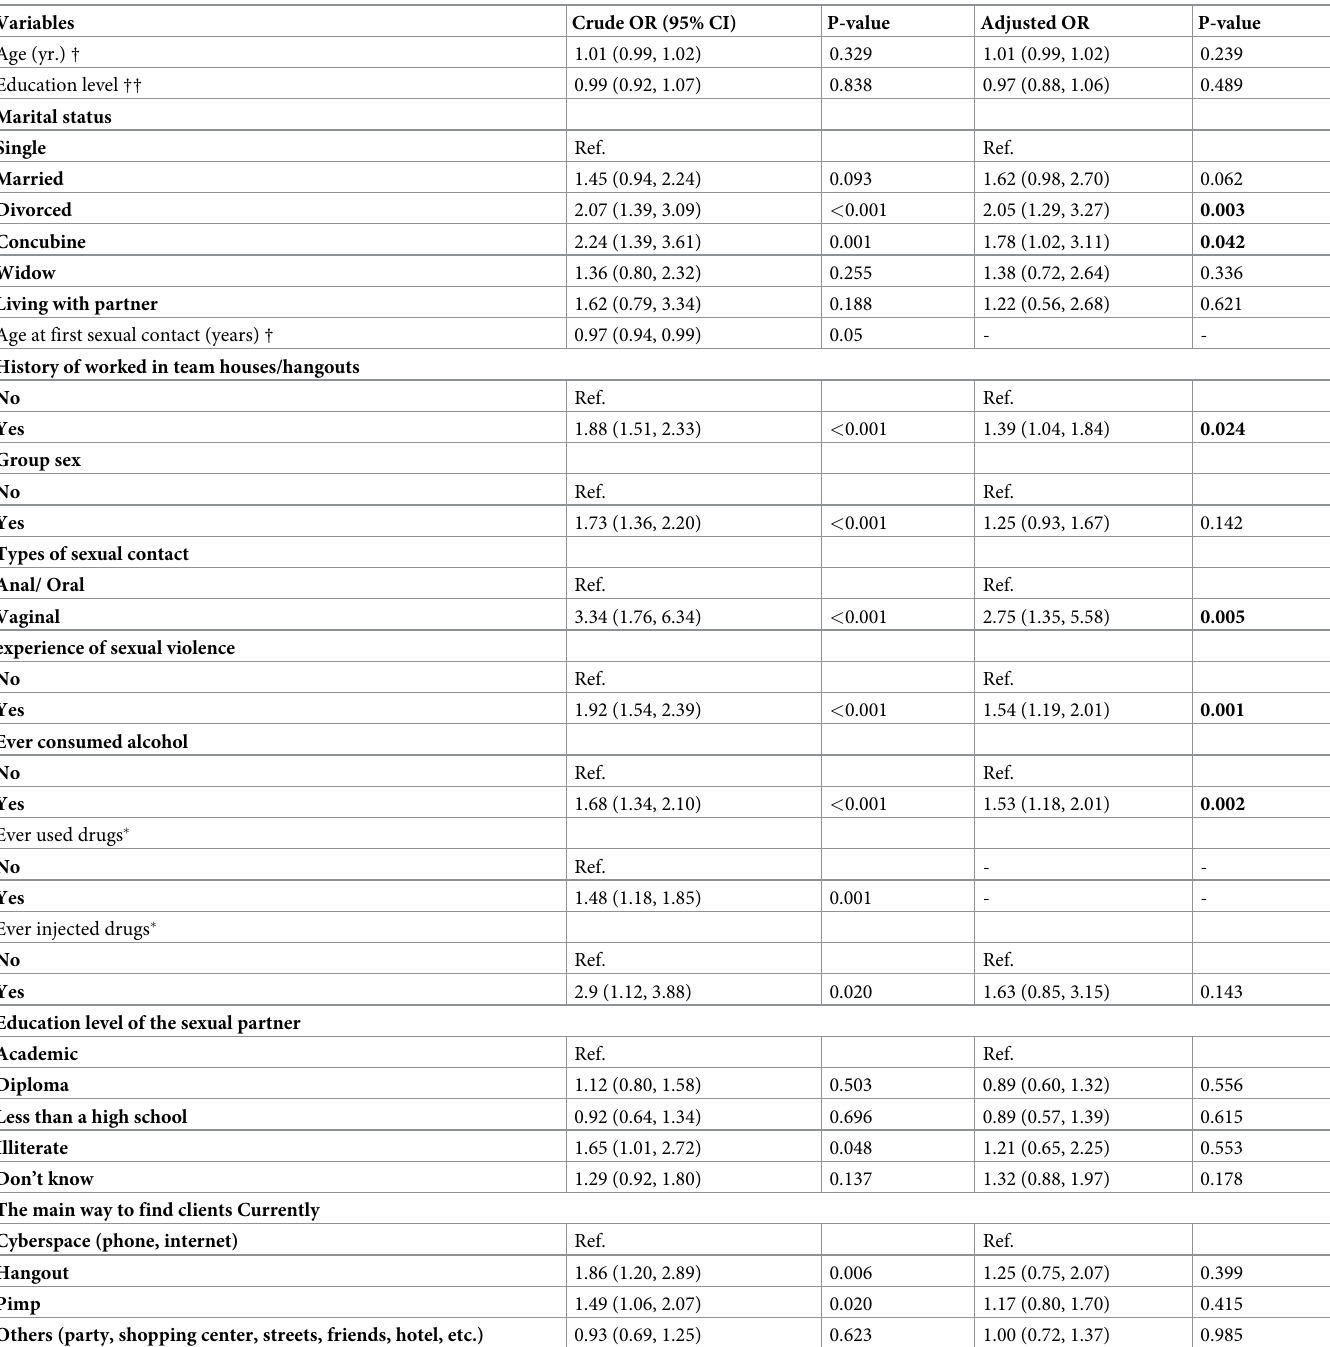
Table 3. Factors associated with intentional abortion among female sex workers in Iran using logistic regression (n =